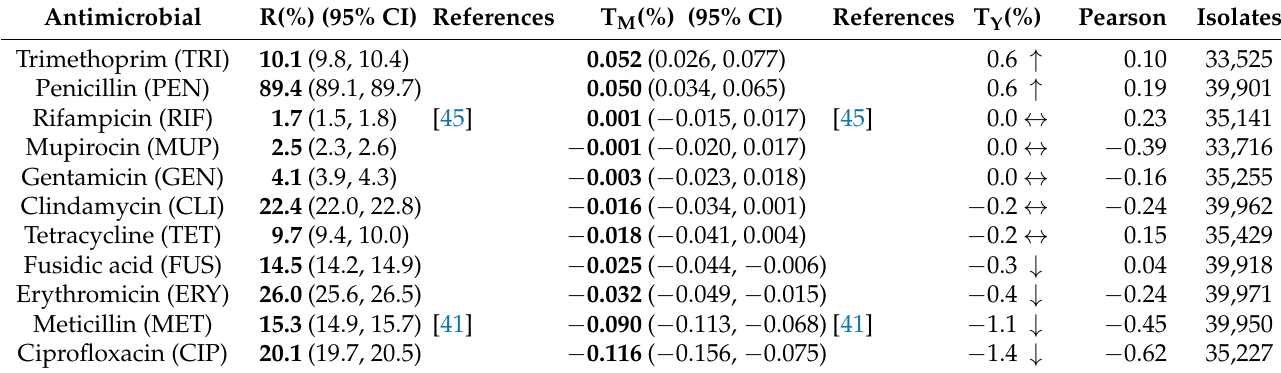
Figure 4. Case study II: E. coli in blood samples. The table presents the resistance index, resistance trend (monthly and yearly), the pearson correlation coefficient, the number of isolates and external resources for validation for each antimicrobial. In addition, the main metrics ( left ) and four examples of resistance time series ( right ) are graphically represented to facilitate comparison. Table 4. AMR summary for S. aureus in wound